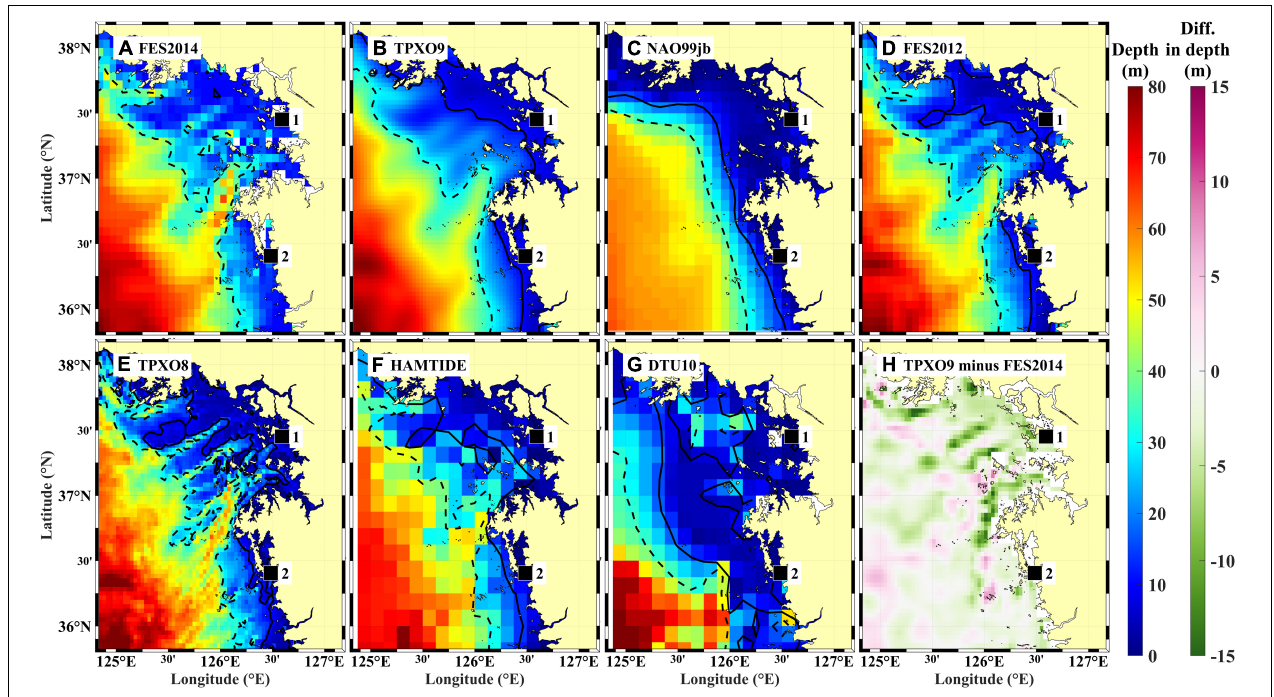
FIGURE 7 | Bathymetries in and around Gyeonggi Bay applied in seven ocean tide models ( A: FES2014, B: TPXO9, C: NAO.99jb, D: FES2012, E: TPXO8, F: HAMTIDE11a, and G: DTU10). Color scale for each panel is shown at right of figure (water depth in m), alongside horizontal resolution corresponding to each model. Black solid and dashed lines in (A–G) denote iso-depths of 10 and 30 m, respectively. In (H) , difference in bathymetric representation between TPXO9 and FES2014 models is shown with 1/30 ◦ horizontal resolution. Locations of two TG stations (IC and BR) are denoted by black